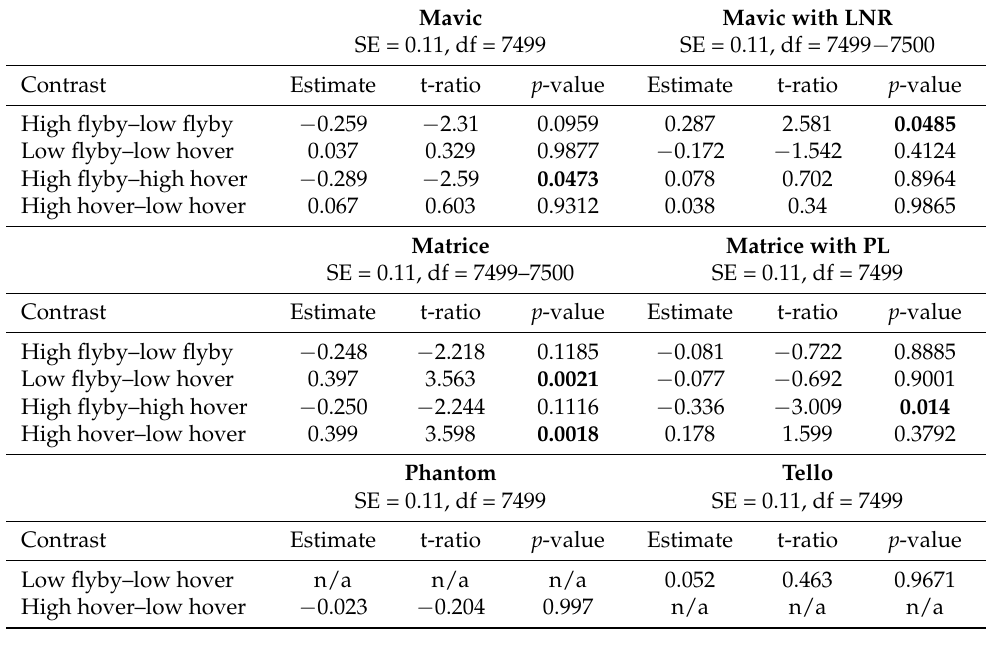
Table A4. Pairwise contrasts of distraction scores between the UAVs. p -values in bold represent statistical significance (<0.05). Low, Hover Low,